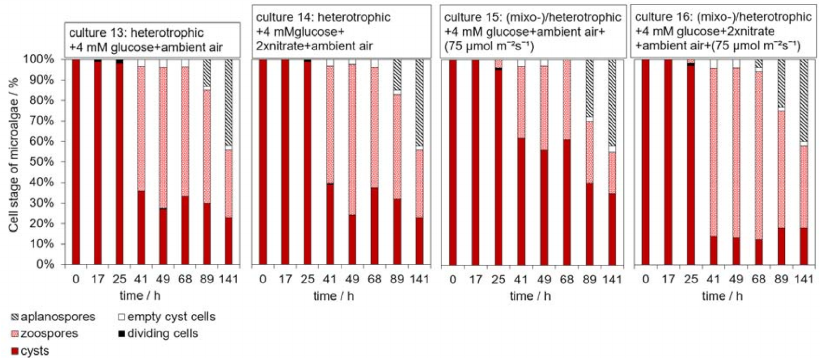
Figure 10. Astaxanthin concentration in the ethyl acetate extract of the heterotrophic culture 13 (heterotrophic + 4 mM glucose + ambient air) and culture 14 (heterotrophic + 4 mM glucose + 2xnitrate + ambient air), and culture 15 (mixo-/heterotrophic + 4 mM glucose + ambient air + (75 µ mol m − 2 s − 1 ) and culture 16 (mixo-/heterotrophic + 4 mM glucose + 2xnitrate + ambient air + (75 µ mol m − 2 s − 1 ); data obtained by single determination.